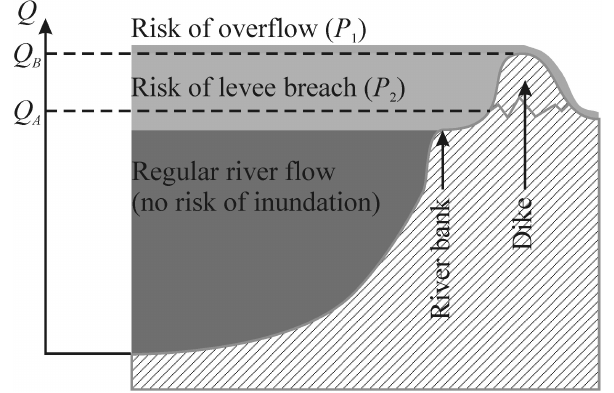
Fig. 2. Two reasons of inundation – an illustration. the duration ( d) of flow over the flow level Q A and of the pdf of the d duration, so f (d) for annual peak flows in the interval Q A < Q max (t) < Q B